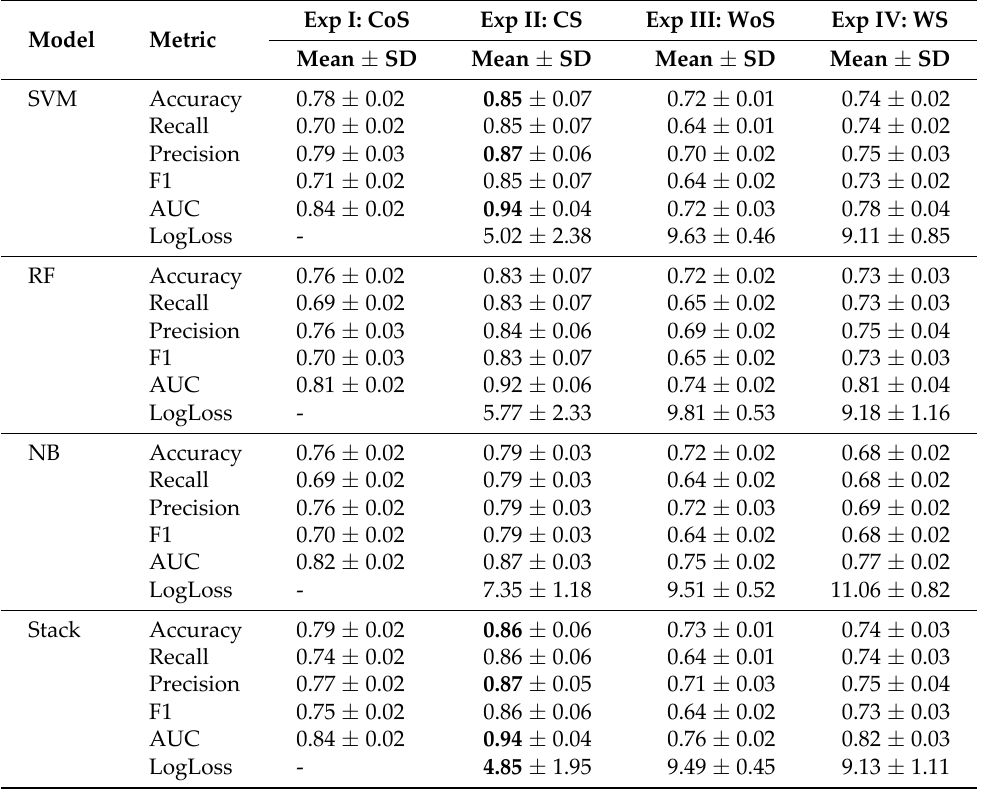
Table 4. Comparison of Performance of Ensemble Classifier over base learners using TF‑IDF char‑ acter (1,7) grams with (no) SMOTE and TF‑IDF word uni‑gram with (no) SMOTE and using CV